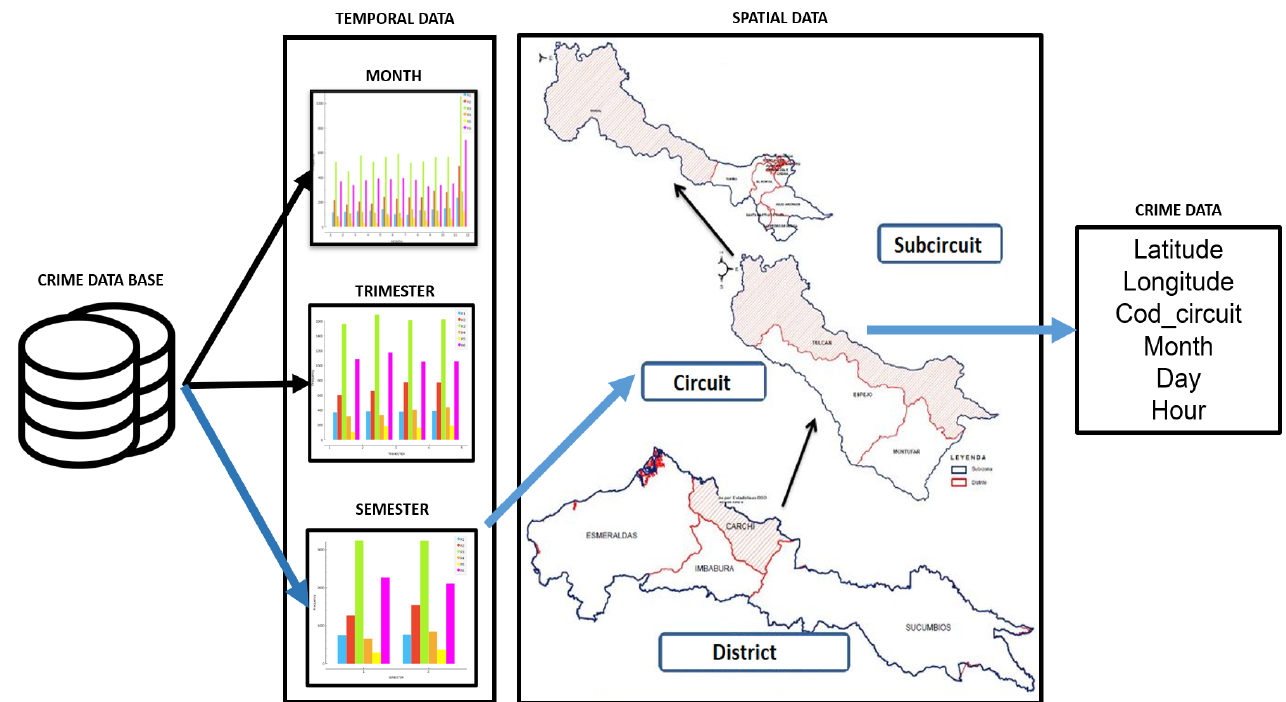
Figure 1. The analysis process of a Crime Database.